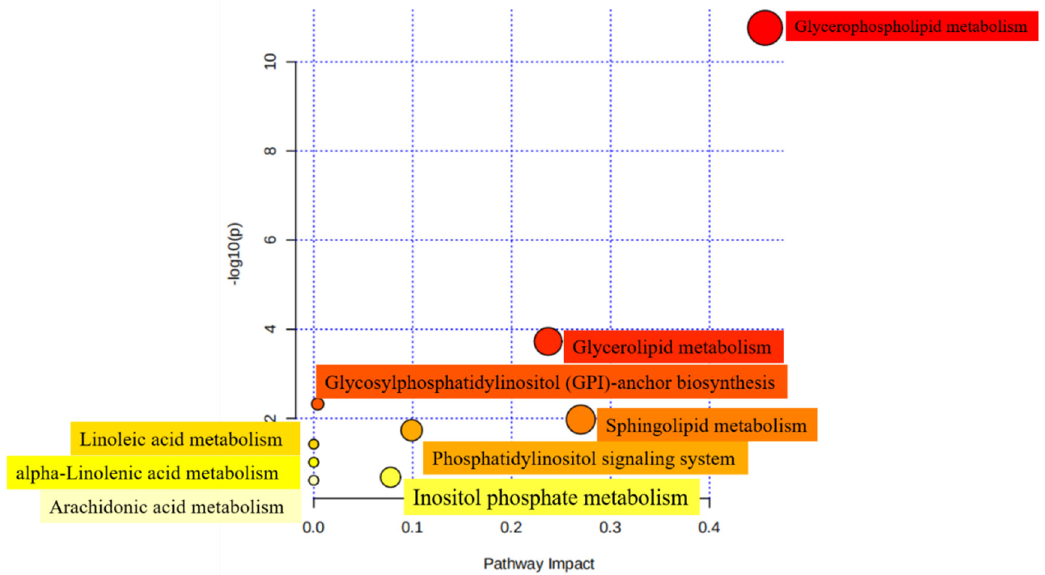
Figure 6. Metabolomic view of the significant lipid biosynthetic pathways in HM and IFs. Larger sizes and dark colors represent major pathway enrichment and high pathway impact values.